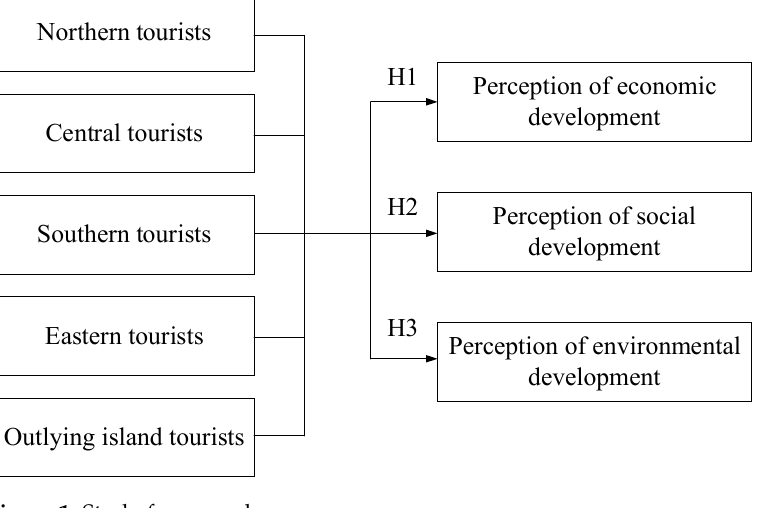
Figure 1. Study framework.